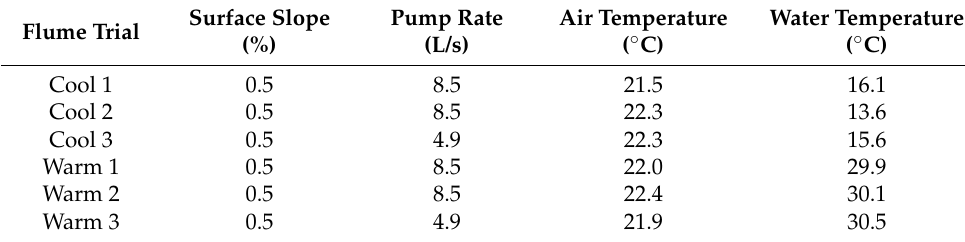
Table 1. Initial physical model parameters.